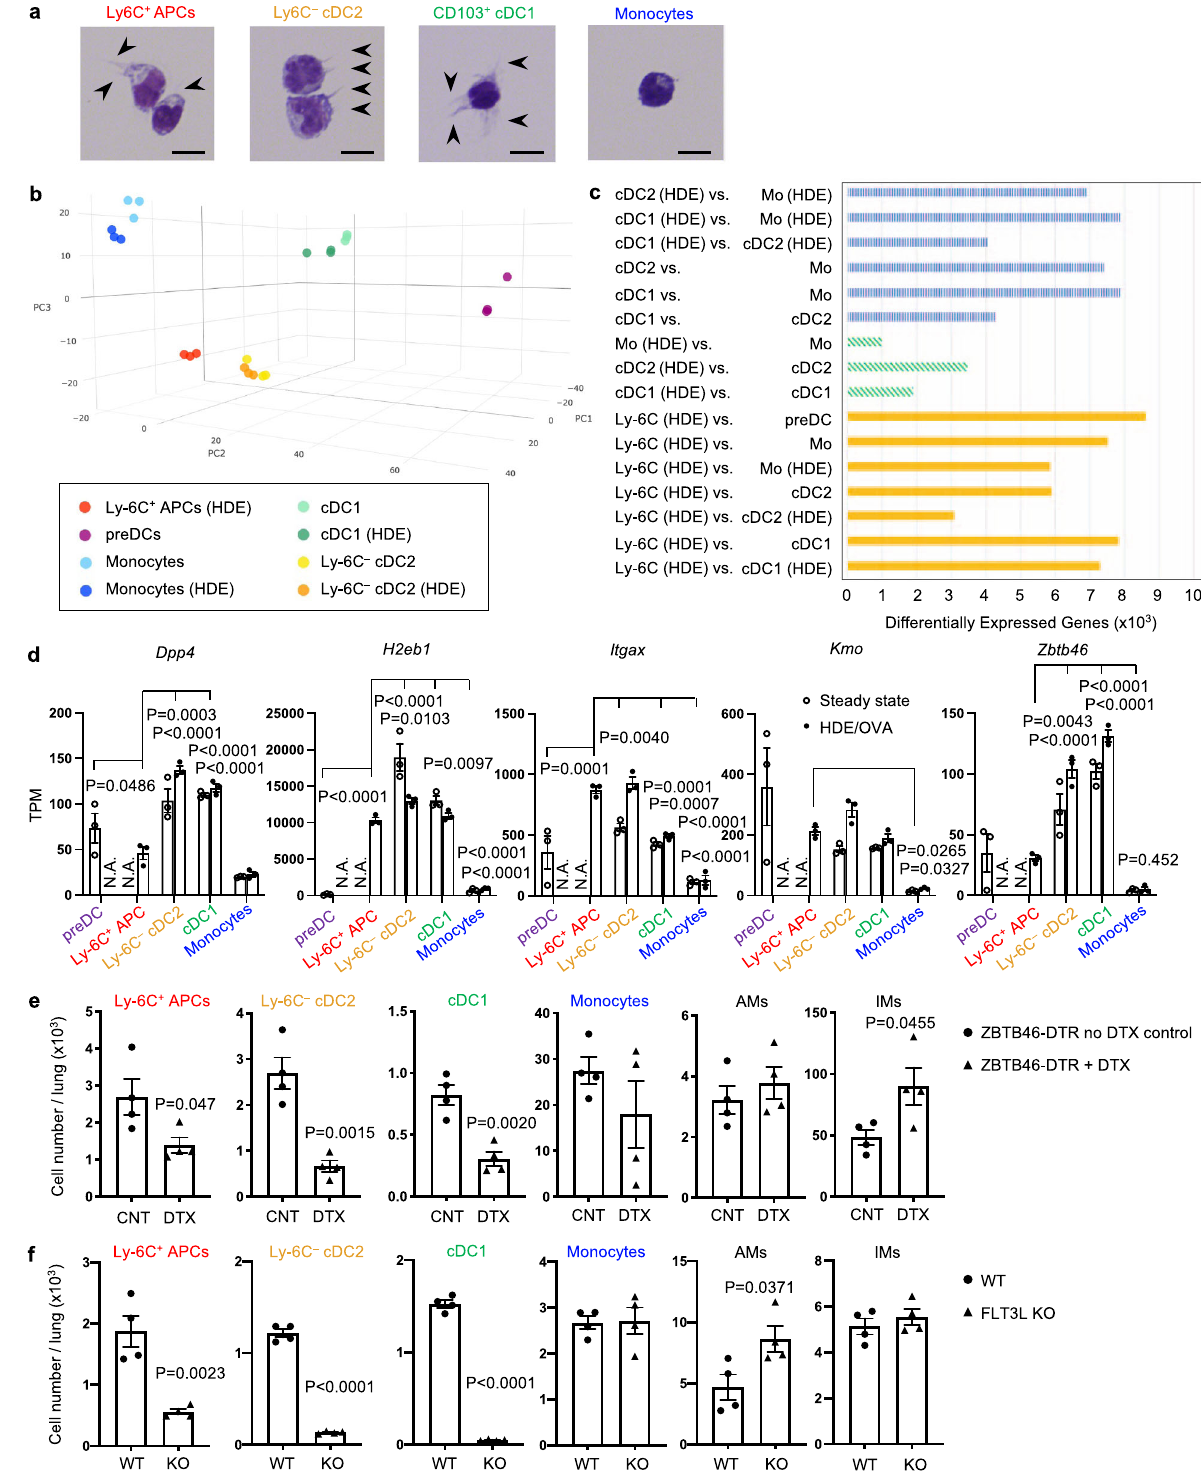
Fig. 2 Lineage analysis of HDE-induced Ly-6C + APCs. a Morphology of HDE-induced Ly-6C + APCs, Ly-6C – cDC2, cDC1, and monocytes puri fi ed by fl ow cytometry. Dendrites are indicated by arrowheads. Bars denote 10 μ m. A representative result from two independent experiments is shown. b Principal component analyses of RNA-Seq data for these same cell types isolated from mouse lungs at steady state and 16 h after HDE/OVA inhalation (HDE). c Number of DEGs between the indicated pairs of cell populations. Mo: monocyes. d Expression of cDC-signature genes is shown as transcripts per million (TPM) from RNA-Seq analysis. Data were analyzed by two-way ANOVA with Fisher ’ s LSD multiple comparison test ( n = 3). Data are presented as mean ± SEM. e , f Cell numbers for indicated cell populations in HDE/OVA-treated Zbtb46-DTR mice (C57BL/6 background) with or without DTX treatment ( e ), or HDE/OVA-treated WT or FLT3L KO mice (C57BL/6 background) ( f ), as determined by fl ow cytometry. The gating strategy is shown in Supplementary Fig. 3b. Data were analyzed by unpaired two-tailed t -test ( n = 4). Data are presented as mean ± SEM. A representative result from two independent experiments is shown. Source data are provided as a Source Data fi le. NATURE COMMUNICATIONS| (2021) 12:5029